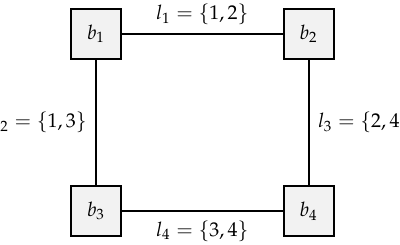
Figure 1. Illustrative graph of a 4-bus power system.